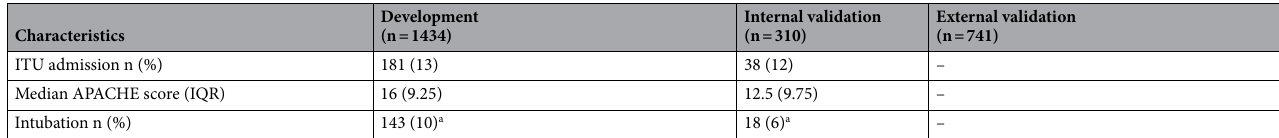
Table 1. Comparison of development, internal and external dataset characteristics. RT-PCR, reverse transcription polymerase chain reaction; A&E, Accident and Emergency; WCC, White Cell Count; CRP, C-reactive protein. a Indicates missing data values over 40% (detailed description of the proportion of missing values is presented in Supplementary Fig. 1). b Indicates difference in units: internal dataset ng/ml and external dataset µg/L.